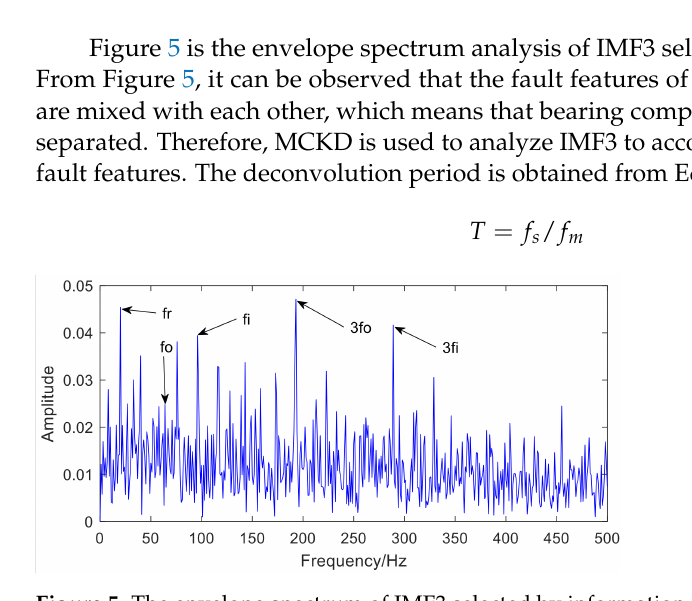
Figure 5. The envelope spectrum of IMF3 selected by information